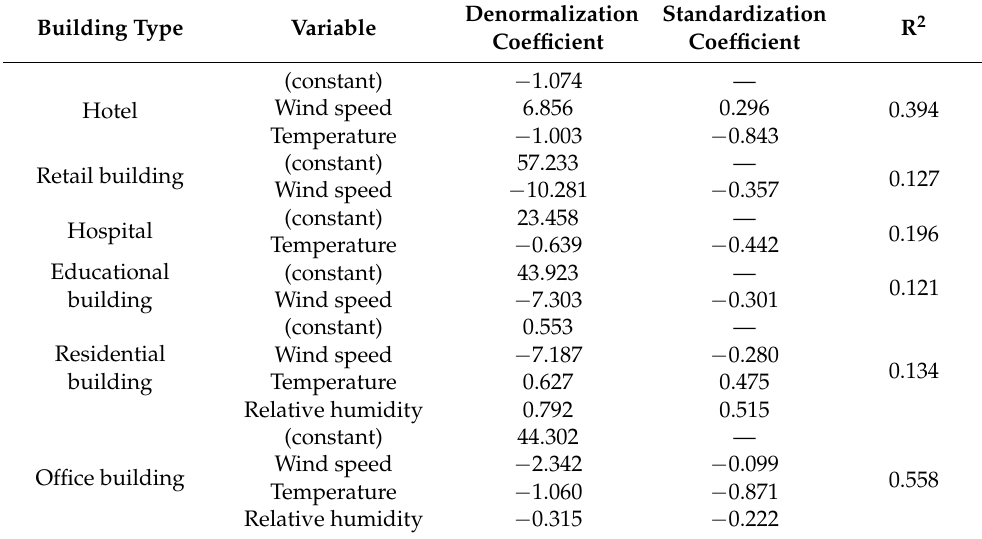
Table 8. Stepwise regression results of climate factors and building heating